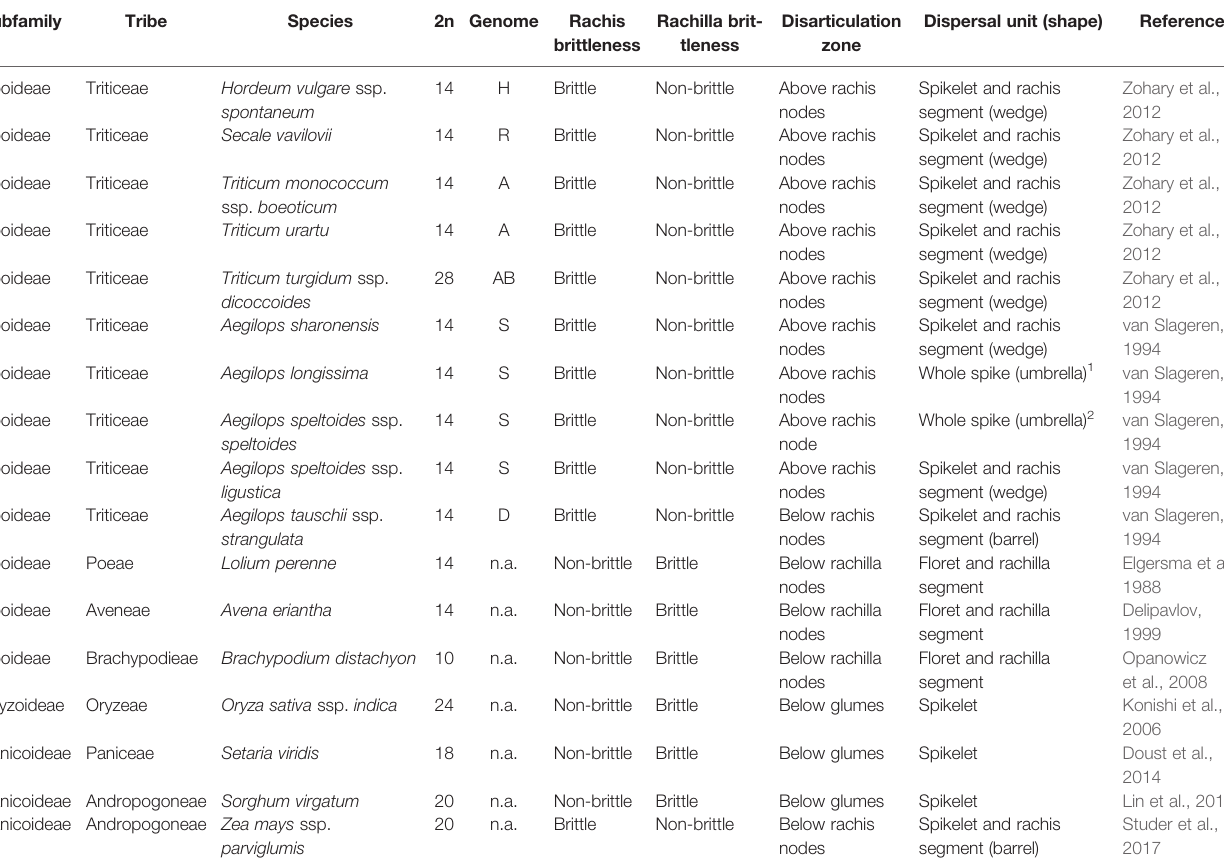
TABLE 1 | Seed shattering characterized in the set of wild Poaceae